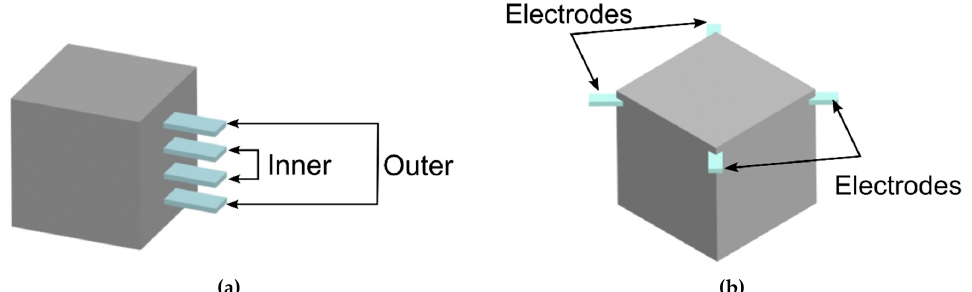
Figure 3. Electrode array for AAM sensing applications ( a ) serial arrangement ( b ) Van der Pauw